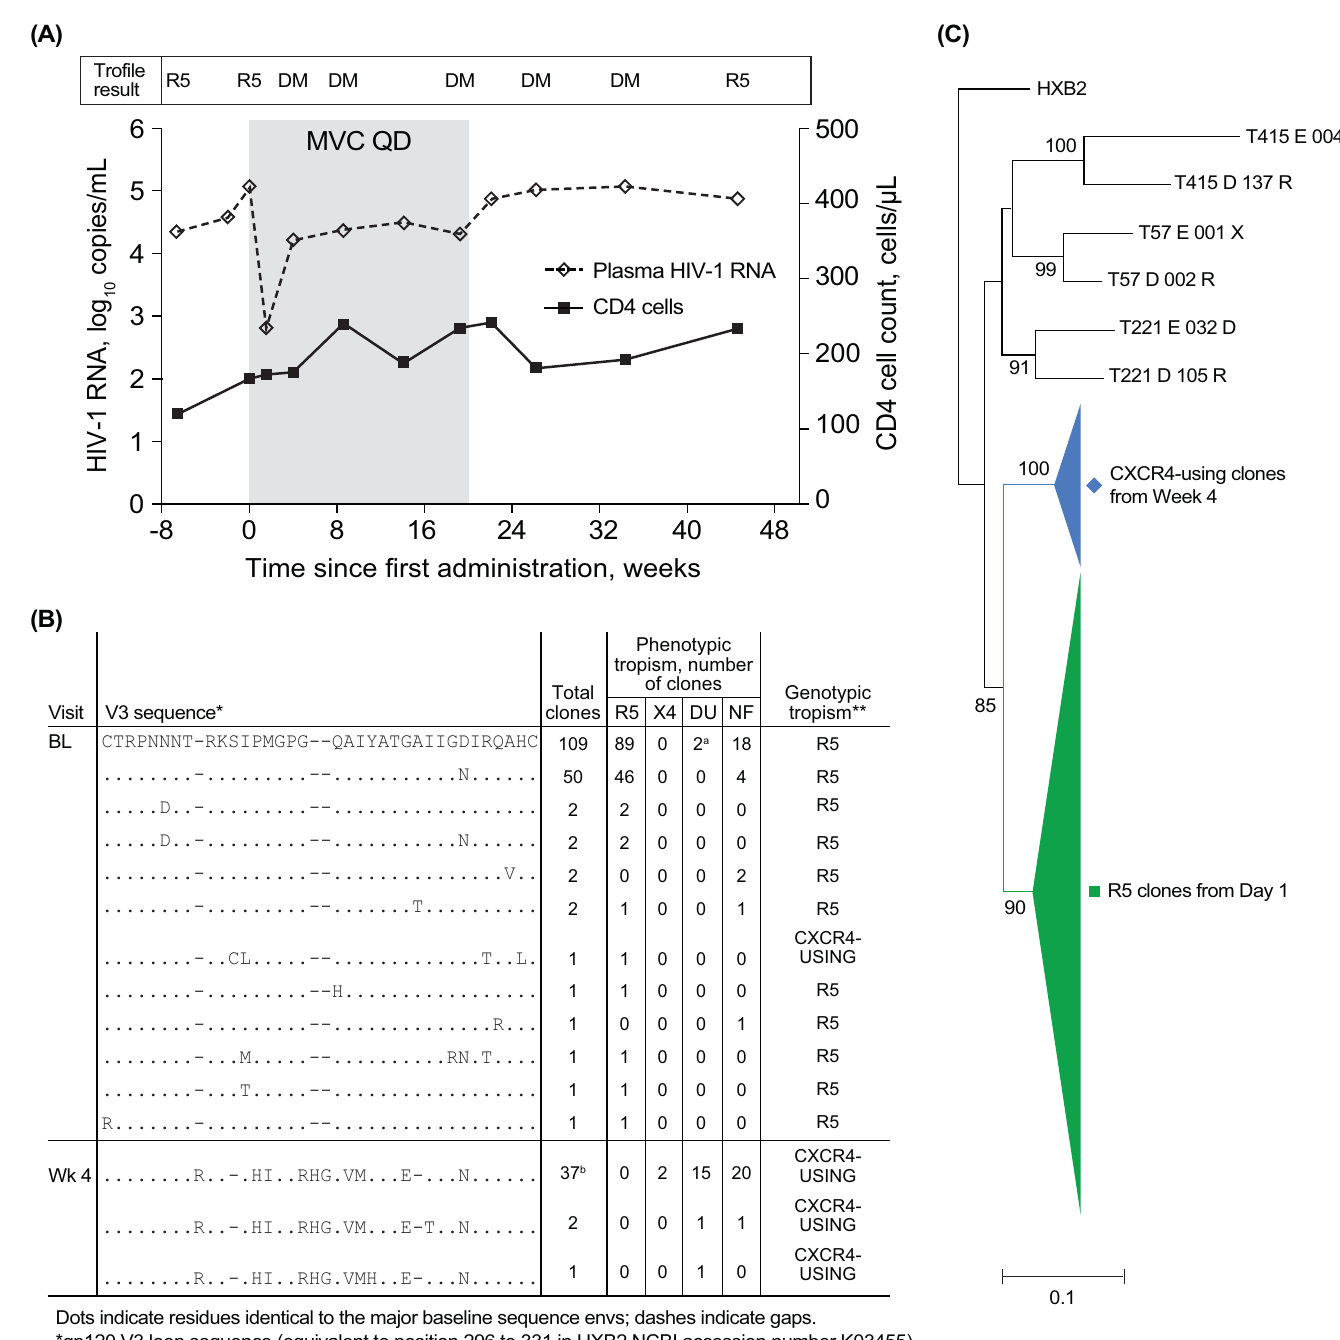
Dots indicate residues identical to the major baseline sequence envs; dashes indicate gaps. *gp120 V3 loop sequence (equivalent to position 296 to 331 in HXB2 NCBI accession number K03455). **Genotypic tropism was assessed using the Geno2Pheno analysis with cut-off <10% FPR=CXCR4-using. a These 2 clones were reassigned as R5 following tropism confirmation. b There were also 4 individual clones, each with 1 different amino acid substitution relative to this sequence; all were non-functional. Fig 3. An example of a participant with no CXCR4-using env clones detected in the Day 1 sample. (A) Change in viral load ( ^ dashed line) and CD4 ( ▪ solid line) for participant T398, who received maraviroc with no additional active drugs for 134 days (Week 20, shaded area) and failed therapy at Week 8. Viral tropism as measured by the Trofile assay in the clinical program is shown above the plot. Clonal analyses were performed on plasma stored from Day 1 (pre-treatment; plasma HIV-1 RNA, 115,000 copies/mL) and when the tropism of the plasma was assigned as DM at Week 4 (plasma HIV-1 RNA, 16,400 copies/mL). Results of the clonal tropism analysis are shown in the embedded table. (B) V3 sequence alignments and tropism assignments for clones tested at Day 1 (BL) and Week 4 (WK4). CXCR4-using clones from the Week 4 sample shared the same sequence as CXCR4-using clones present as a minority in the Day 1 sample. (C) Diagrammatic representation of a phylogenetic tree for participant T398 based on the neighbor-joining tree. The tree is rooted using HXB2 and includes examples of circulating virus